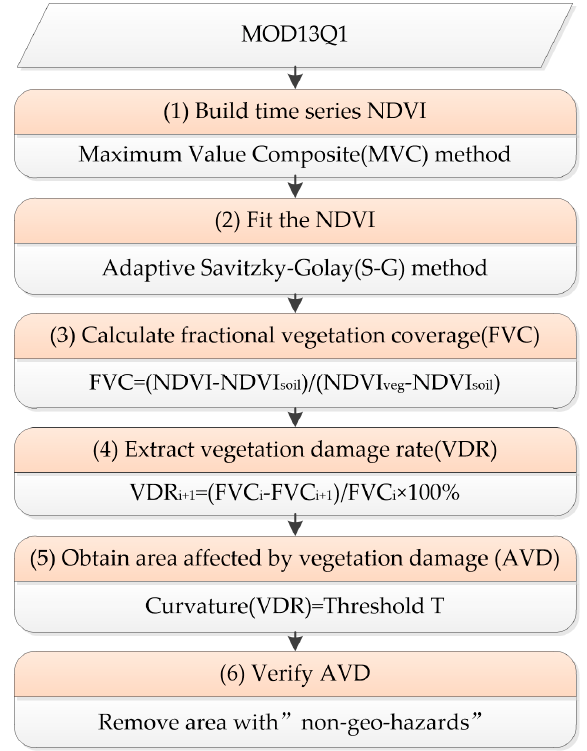
Figure 2. Flow chart of the steps involved in extracting the area affected by vegetation damage caused by geohazards.